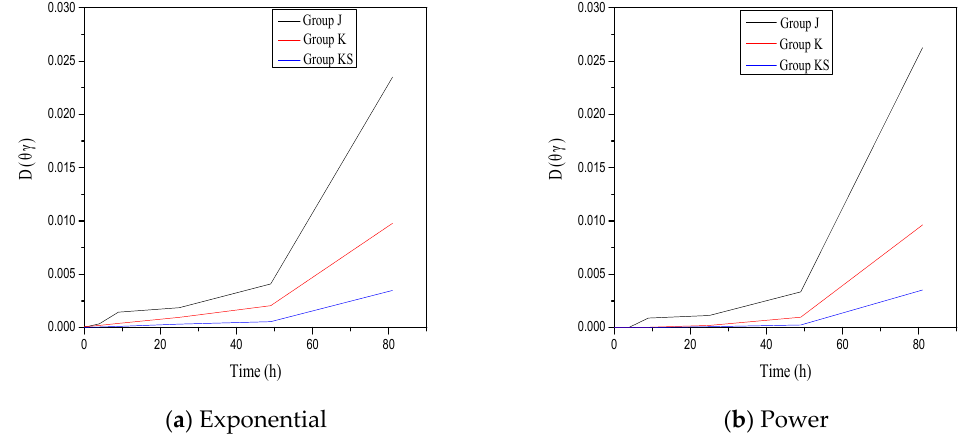
Figure 8. Relationship between 𝐷(𝜃𝛾) and time.